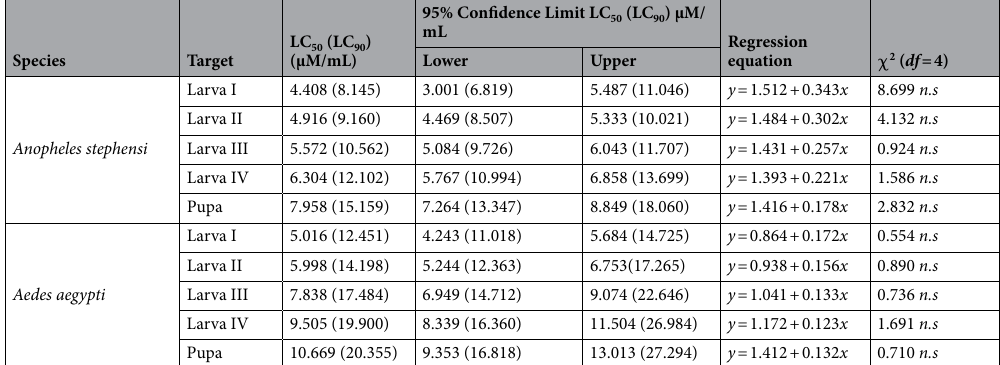
Table 2. Acute toxicity of synthesized 4,7-dichloroquinoline on young instars of Anopheles stephensi and Aedes aegypti. Control no mortality, LC 50 lethal concentration that kills 50% of the exposed organisms, LC 90 lethal concentration that kills 90% of the exposed organisms, χ 2 chi-square value, d.f. degrees of freedom, χ 2 0.05 level of significance indicates homogeneity of results.